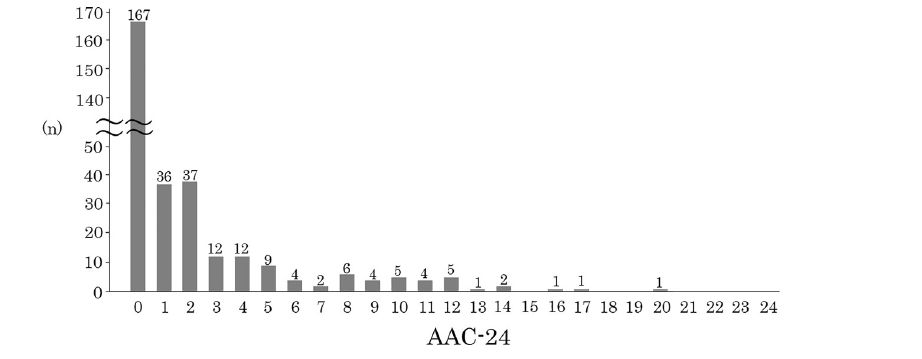
Fig 5. Distribution of AAC-24 scores in all participants (n = 309).